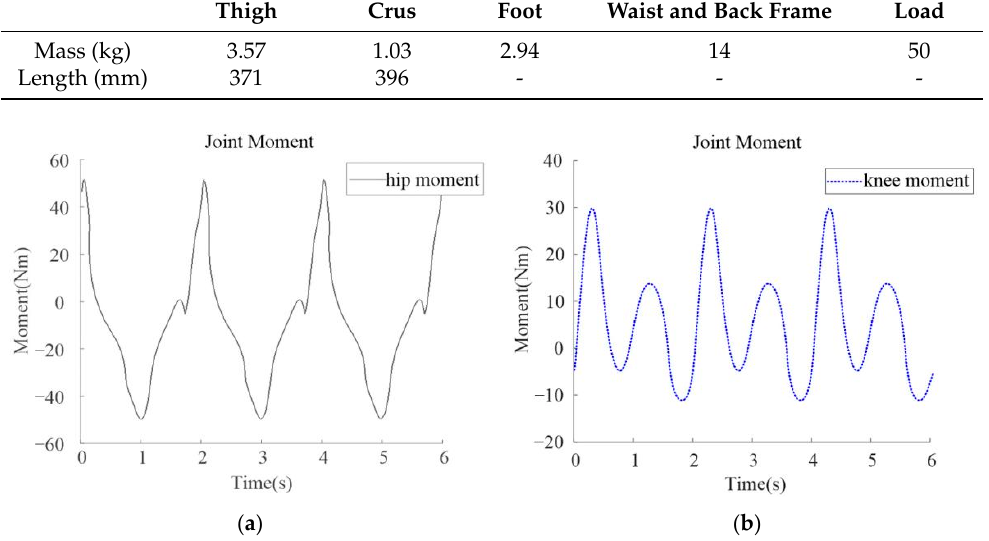
Figure 16. Moment curves for exoskeleton. ( a ) Hip joint moment; ( b ) Knee joint moment. Table 3. The exoskeleton